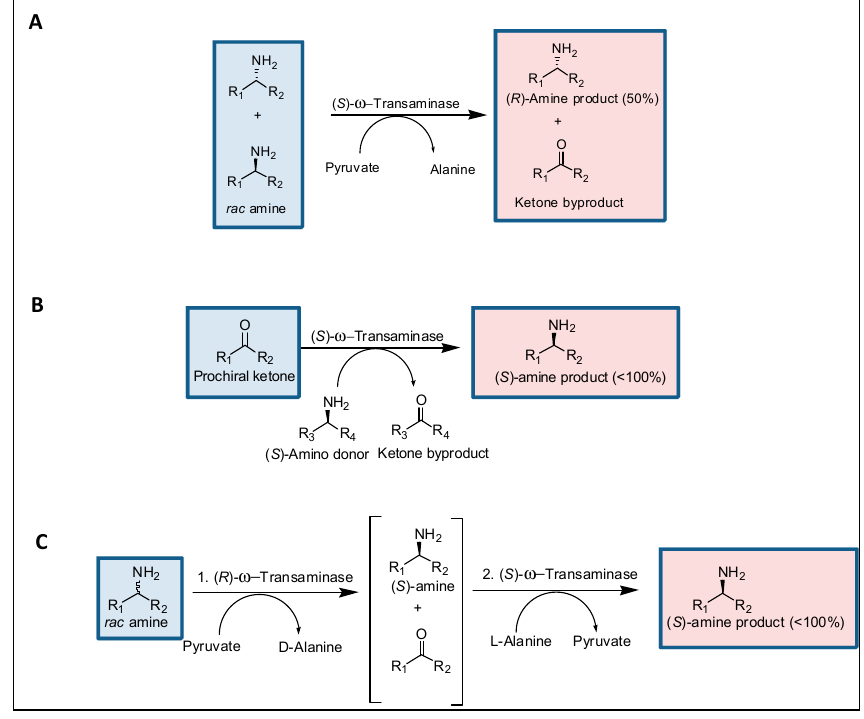
Figure 2. Synthetic approaches for ω -TA-mediated amine synthesis: ( A ) Kinetic resolution with ( S )- ω -TA; ( B ) Asymmetric synthesis and ( C ) Deracemization of racemic amine using ( R )- ω -TA and ( S )- ω -TA. (Adapted from [14], Copyright (2010), with permission from Elsevier).